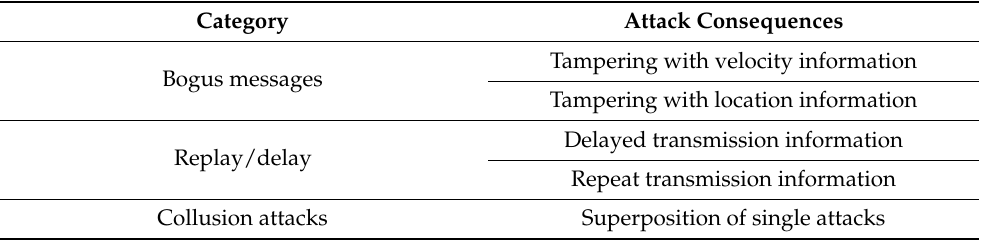
Table 1. Cyberattack classification.